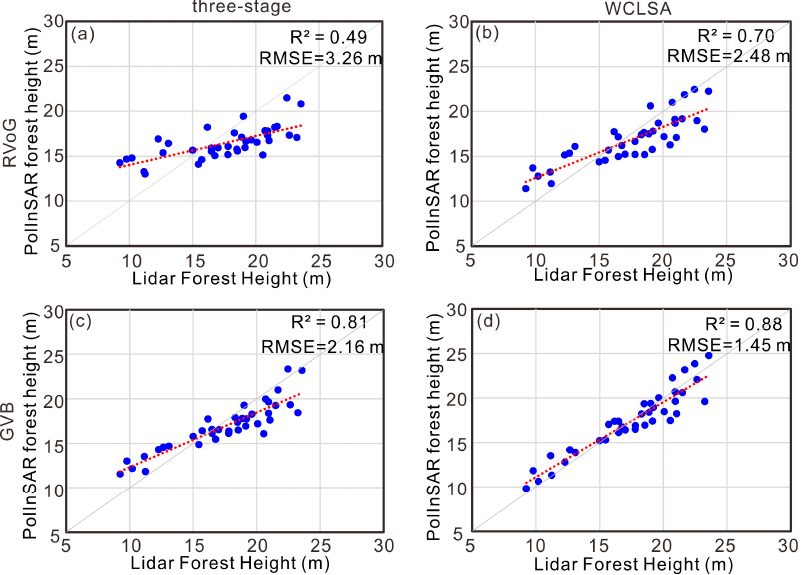
Figure 9. Forest heights estimated by three-stage and WCLSA with: RVoG model ( a , b ); and GVB model ( c , d ), compared with forest height measured by LiDAR.